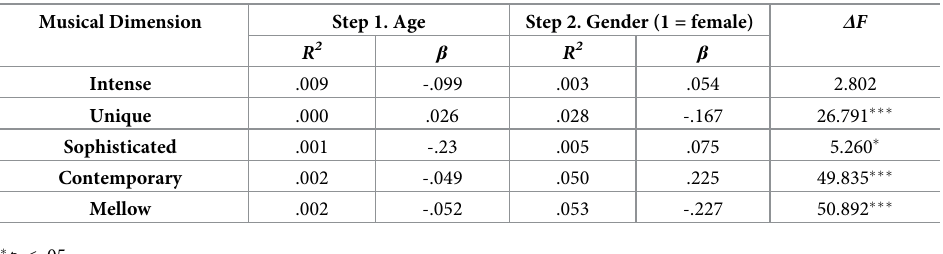
Table 5. Step-wise linear regressions of musical dimensions with age and gender. Musical